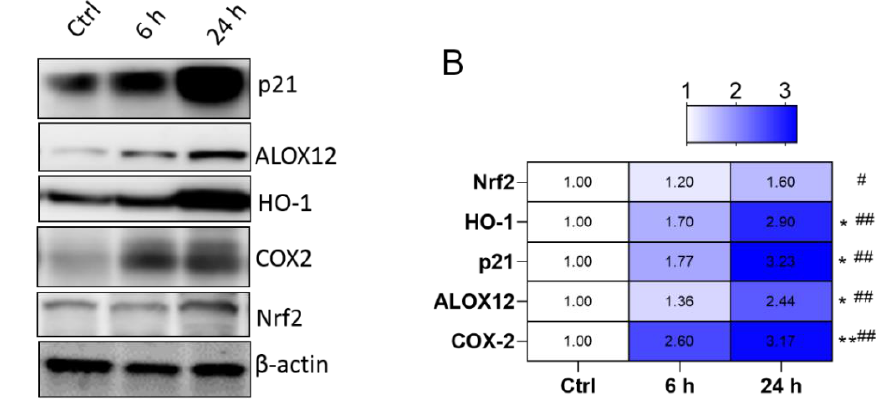
Figure 2. Protein expression levels involved ferroptosis were detected in the liver tissues of mice challenged with CCl 4 . ( A ) Protein expression levels of ALOX12 , HO-1 , COX-2 , p21 and Nrf2 at 6 and 24 h identified by Western blotting analysis of liver tissues of mice treated with CCl 4 ; the quantitative analysis is showed in ( B ) ( n = 4). 6 h vs. ctrl, * p < 0.05, ** p < 0.01; 24 h vs. ctrl, # p < 0.05, ## p < 0.01. Ctrl: control.